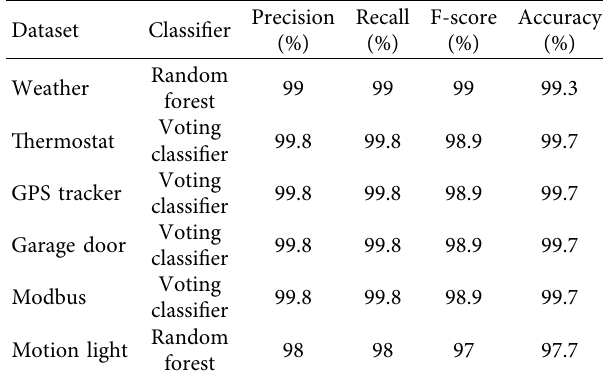
Table 5: Experimental results against each